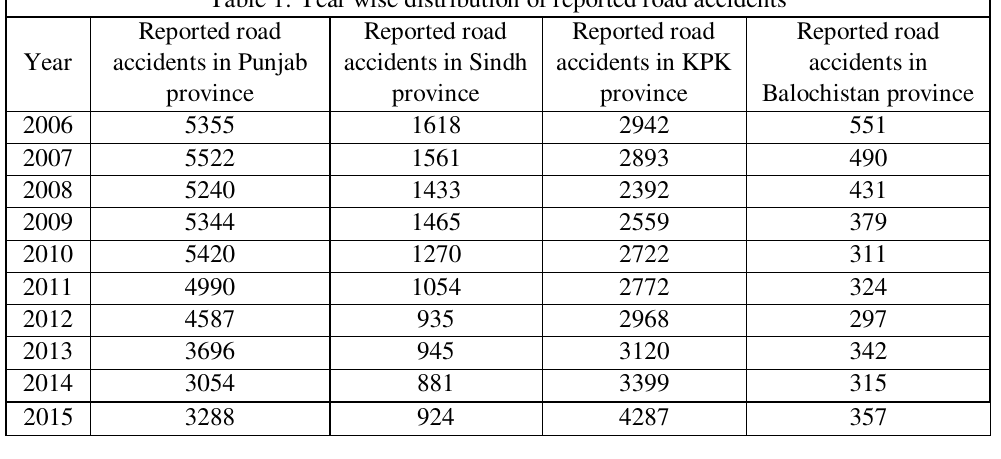
Table 1: Year wise distribution of reported road